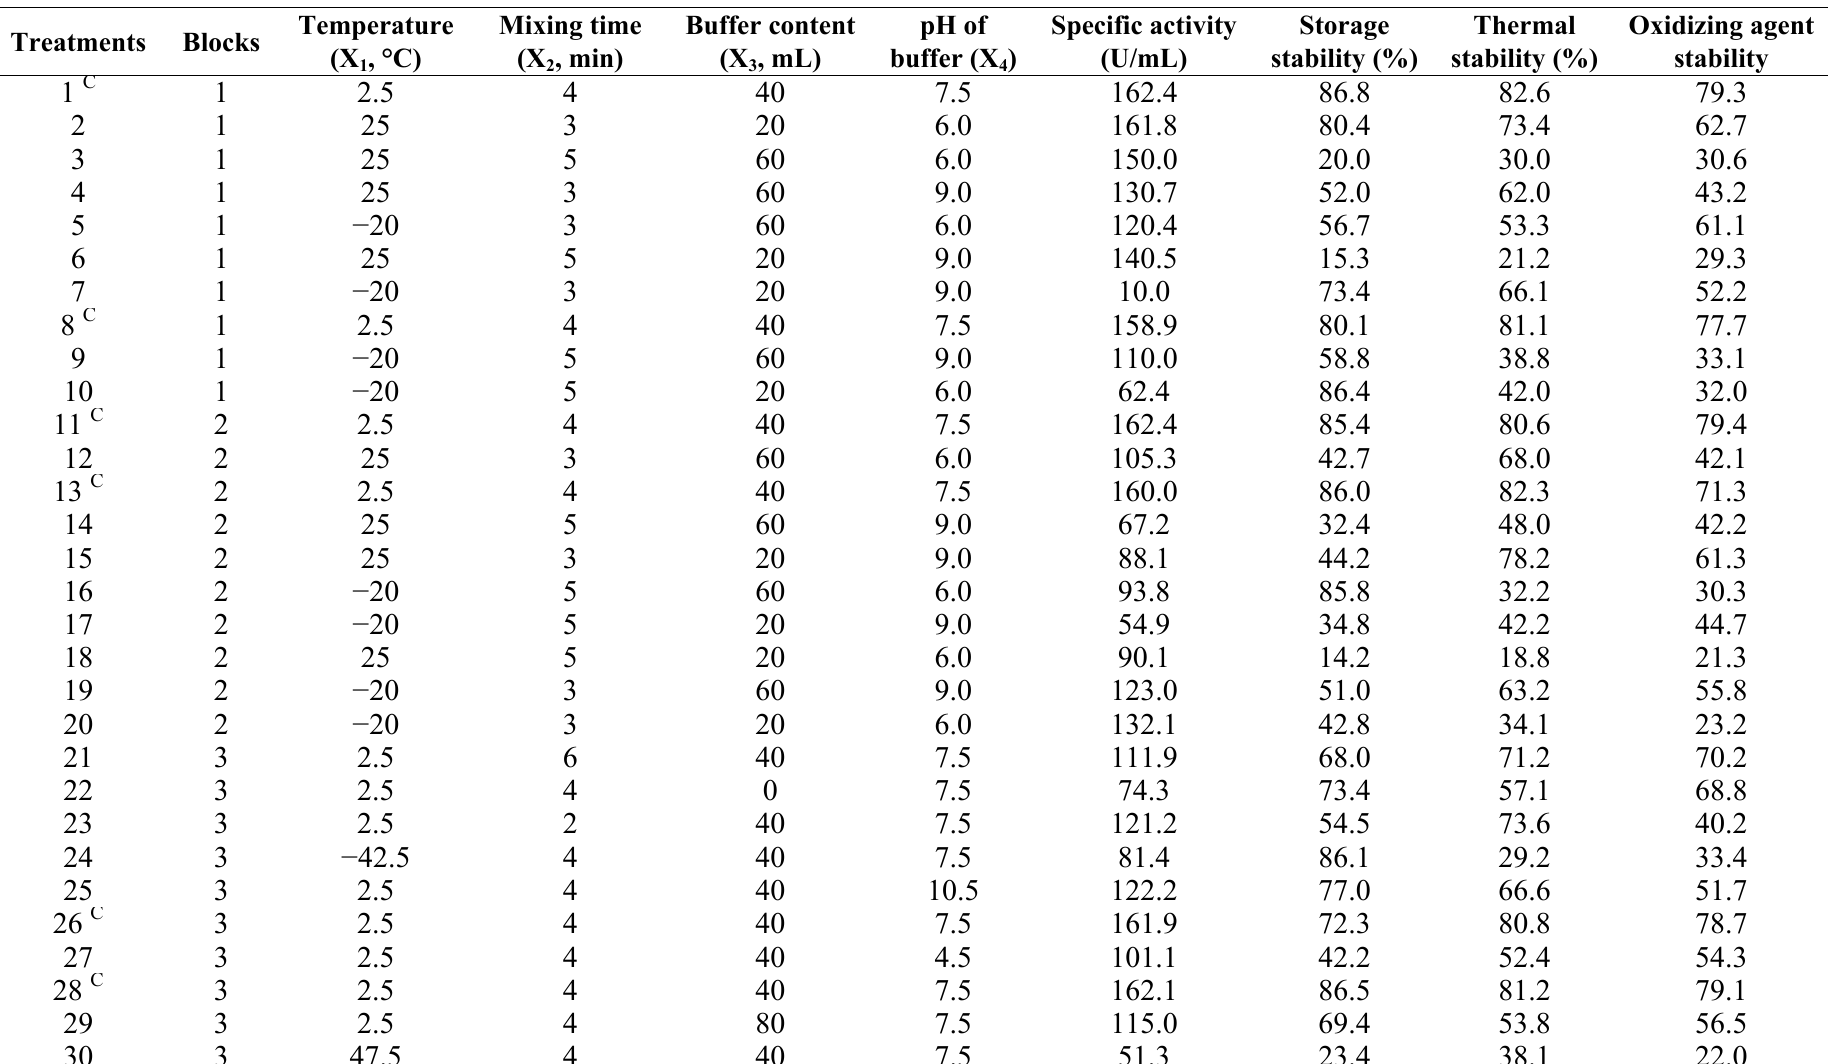
Table 6. Matrix of central composite design